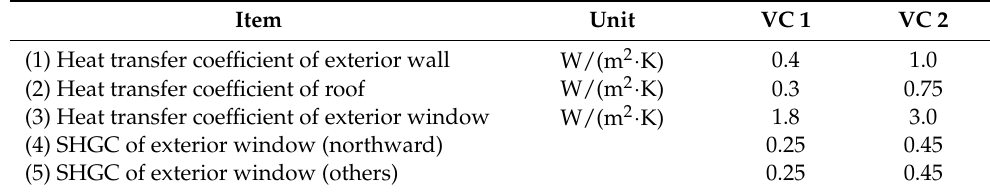
Table 11. Envelope parameters of the buildings in two virtual communities.